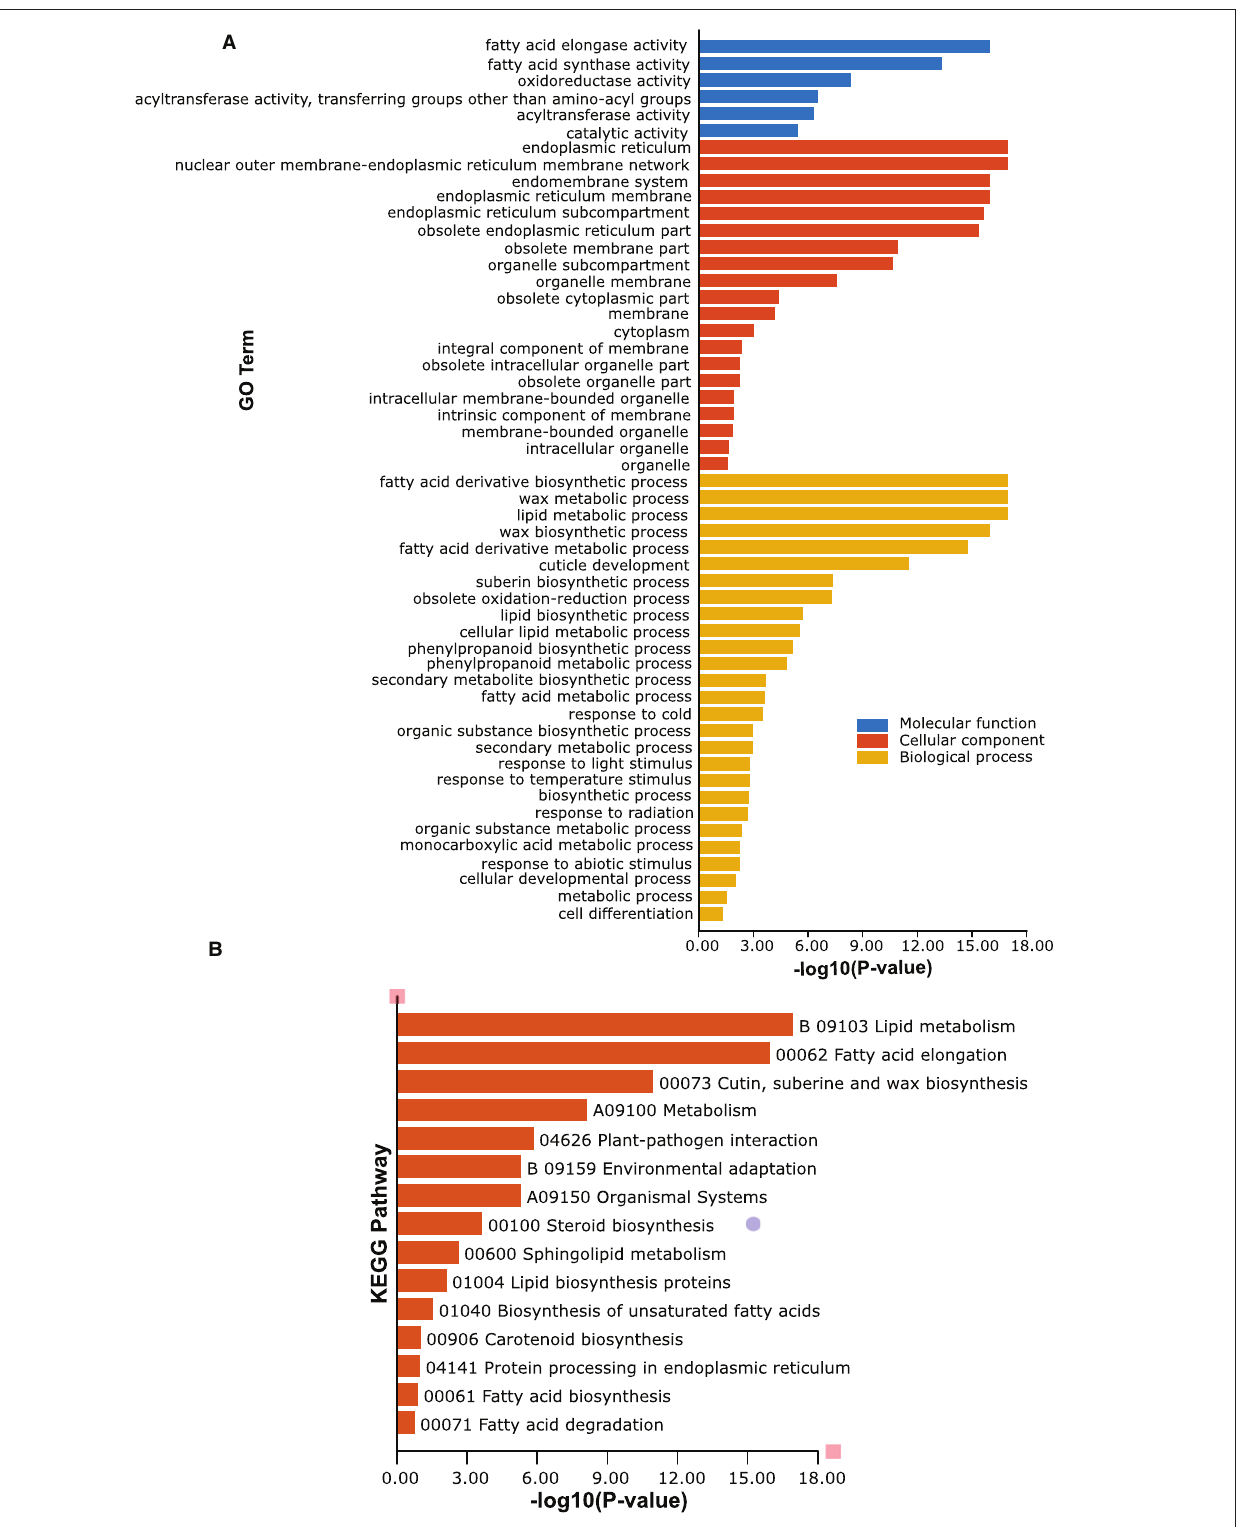
FIGURE 8 | Gene Ontology (GO) and Kyoto Encyclopedia of Genes and Genomes (KEGG) enrichment analyses of PeCER s genes. (A) Highly enriched GO terms in PeCER genes. (B) Highly enriched KEGG pathways in PeCER genes. Further detailed annotation results and numerous significantly enriched terms of MF, CC, BP, and KEGG pathways can be found in Supplementary Tables S14A , S15